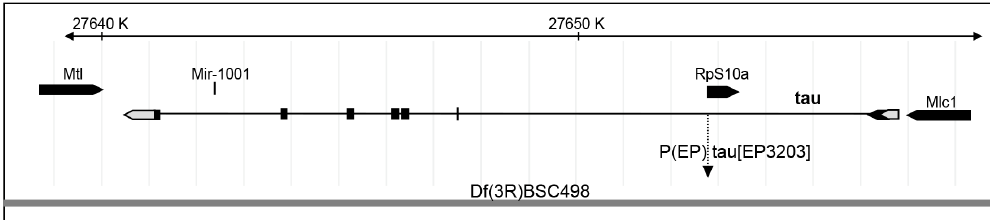
Figure 2. Genomic position of P{EP}tau[EP3203]. Relative position of the P element insertion P{EP}tau[EP3203] within tau gene and deficiency Df(3R)BSC498 on the right arm of the third chromosome. Left is proximal and the distances are indicated in kilobases. Exons are indicated by boxes, which are shaded in black when there is an open reading frame.